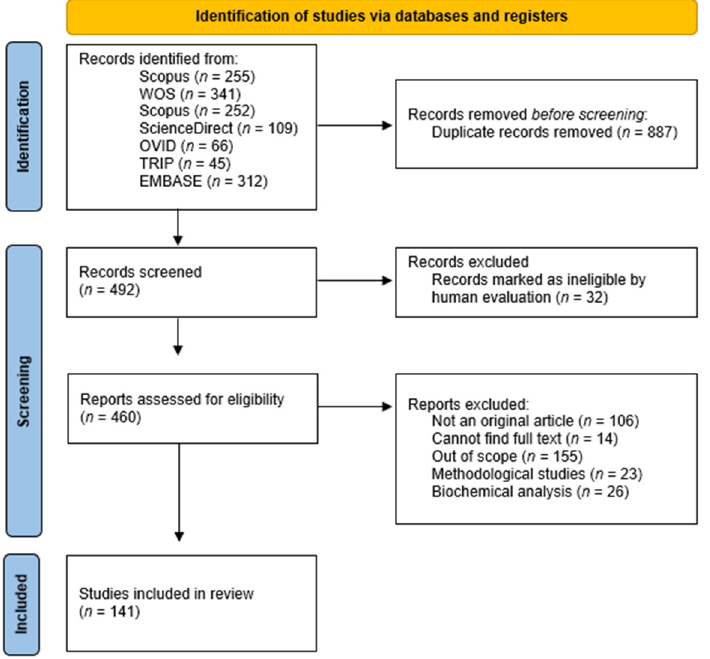
Figure 1. Flowchart representation of the different stages of the selection process.